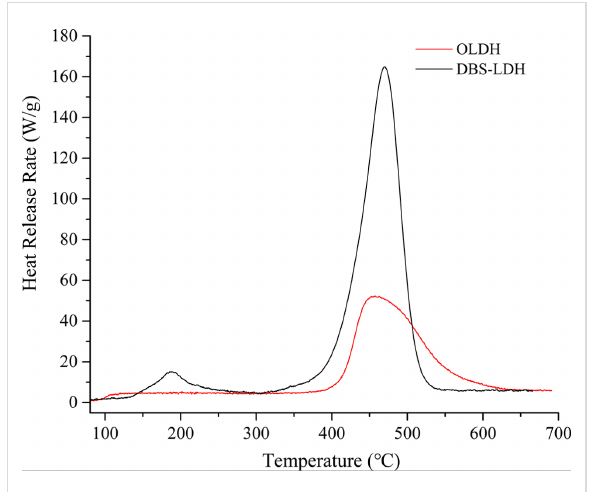
Figure 14: HRR curves of DBS-LDH adapted from [21] and OLDH.